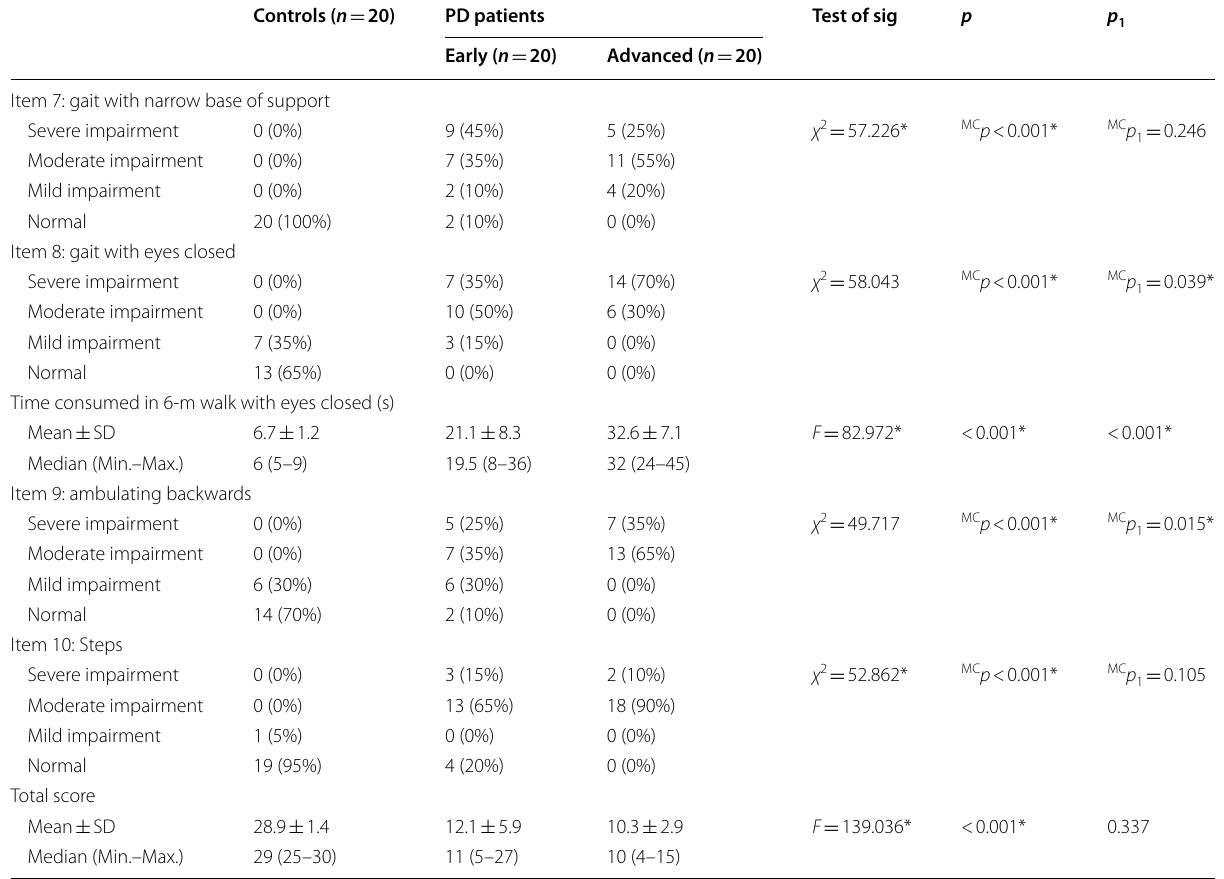
Table 4 Comparison between the studied groups according to functional gait assessment